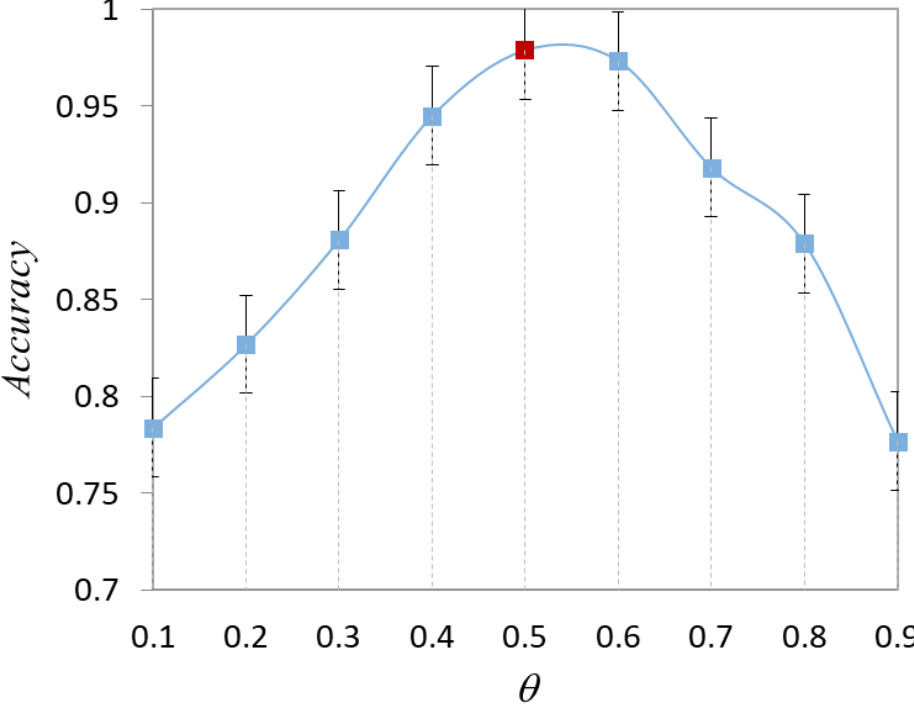
Figure 6. Effect of parameter 𝜃 on model recall. After considering Figures 5 and 6 together, we set 𝜃 = 0.5 for the experiments. As the number of training rounds increases and the experimental data changes, the optimal